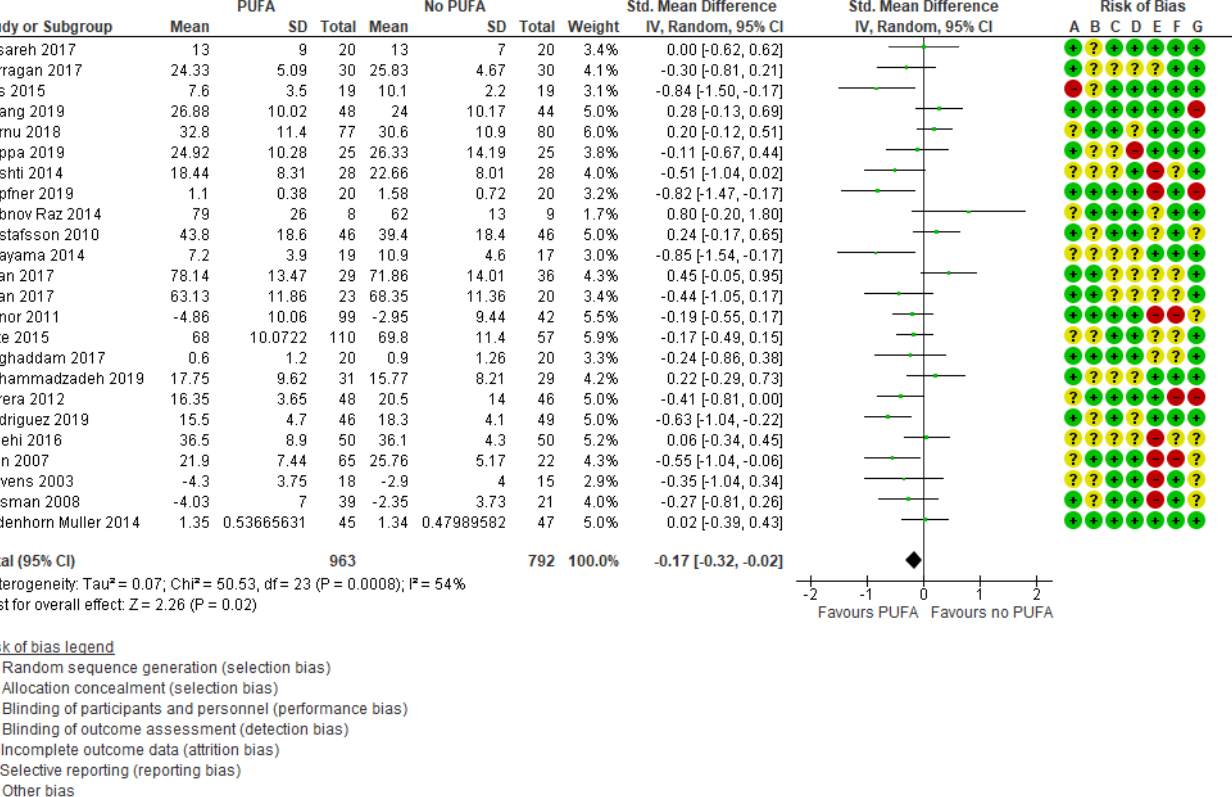
Figure 3. Forest plot of comparison: PUFA vs. placebo, outcome: parent-reported core symptoms (end of treatment). Green square indicates summary estimates of the individual studies. Black diamond indicates total summary effect estimate.